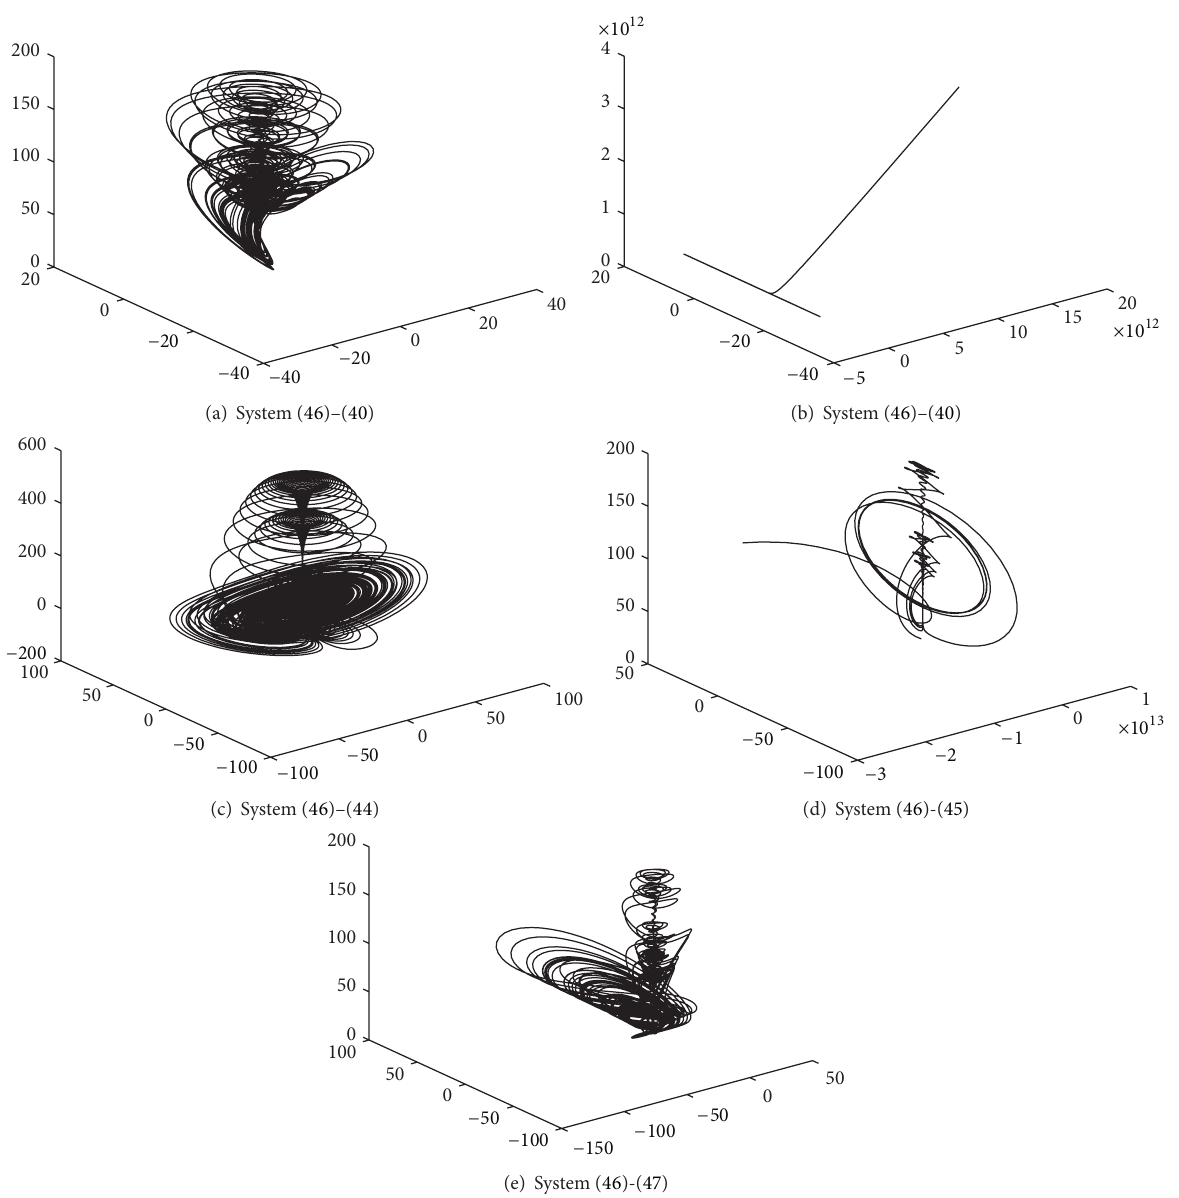
Figure 11: Switched system between Example (46) and